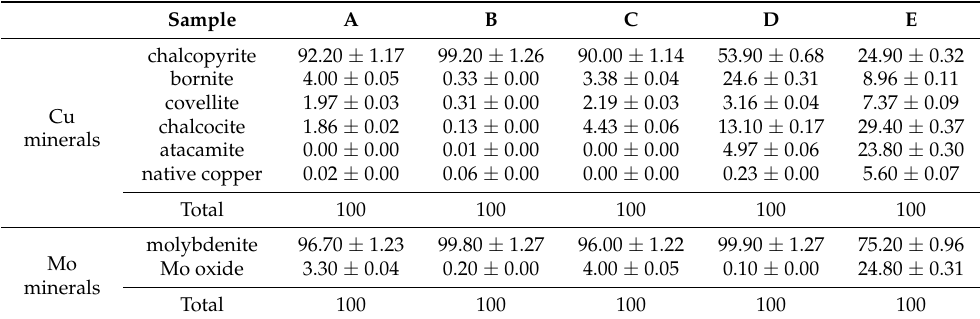
Table 6. Copper and molybdenum mineral composition for each ore sample (wt.%).